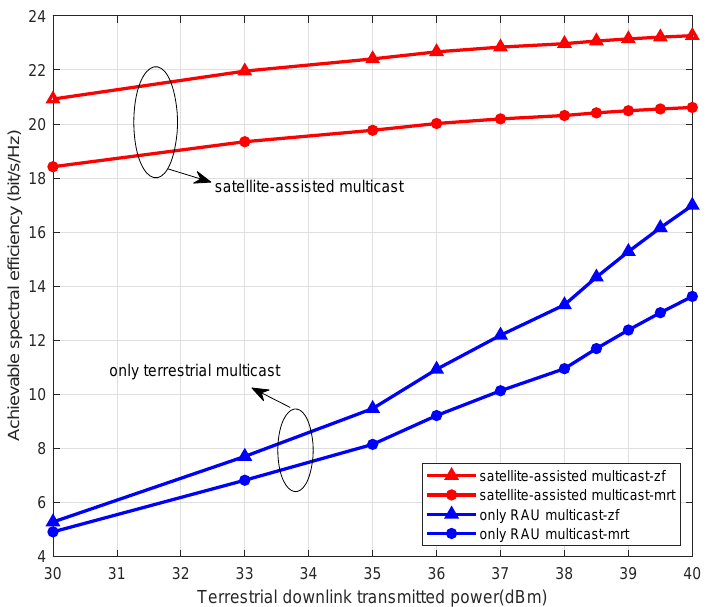
Figure 4. SE against downlink transmitted power under satellite-assisted multicast and only terres- trial multicast.